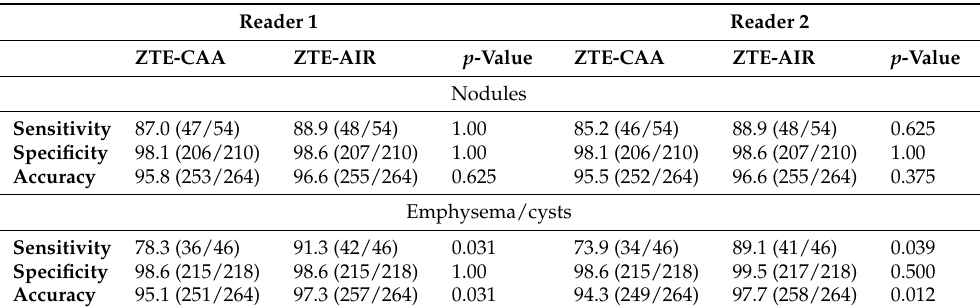
Table 4. Comparison of diagnostic performance for nodules and emphysema on a zone-by-zone basis between ZTE-CAA and ZTE-AIR.